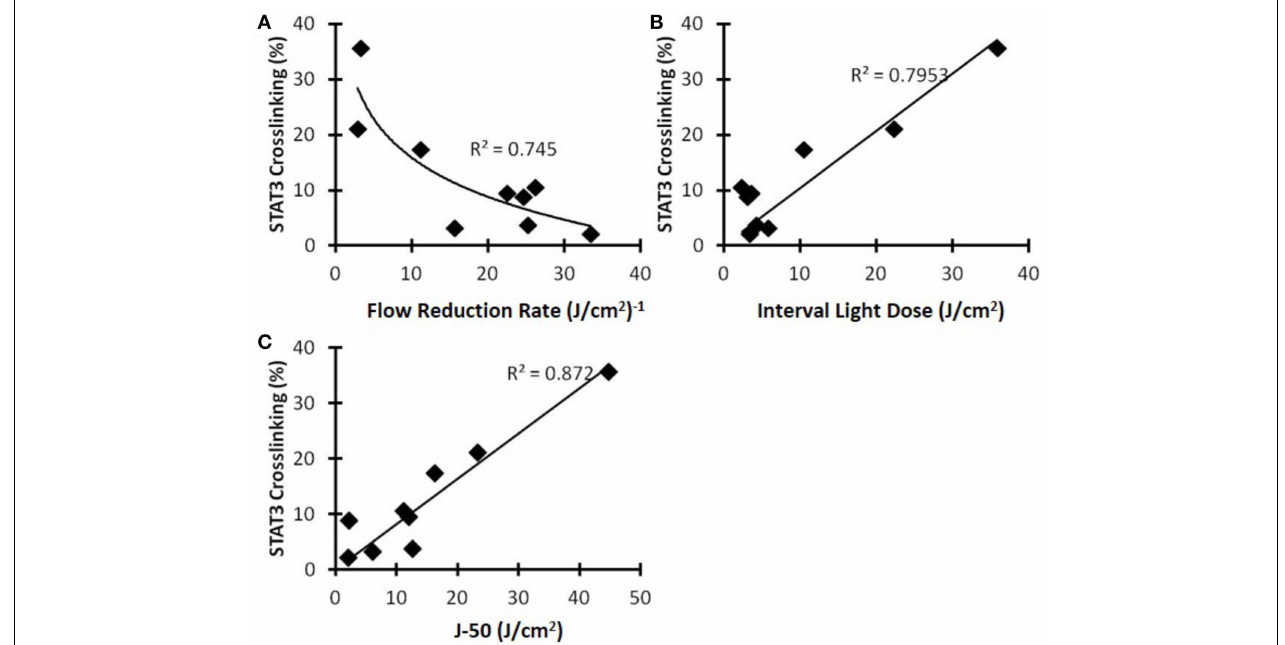
FIGURE 9 | STAT3 crosslinking as a function of various blood flow metrics for the C3H mice with SCCVII tumors. (A) Flow reduction rate, (B) interval light dose, and (C) the new metric J-50.